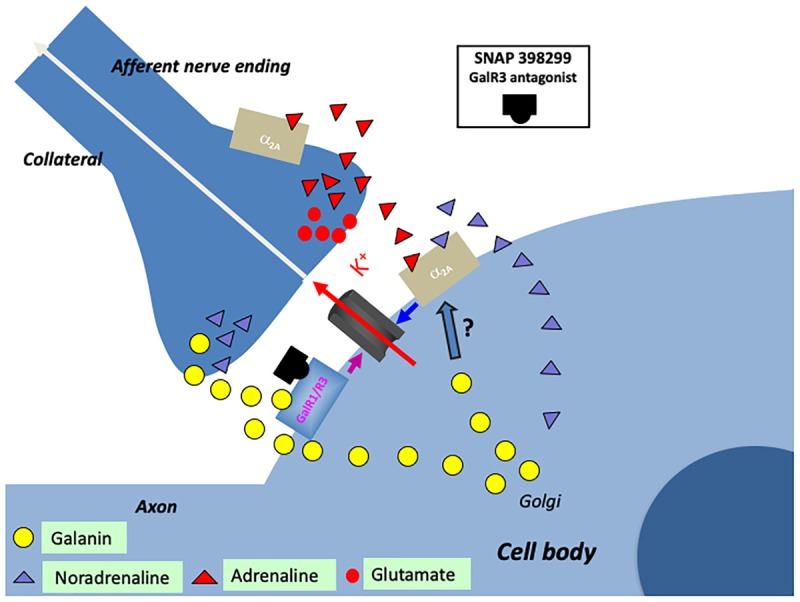
Cartoon showing several transmitters and signaling pathways in the locus coeruleus (LC) (part of a cell body with initial axon and an afferent nerve ending and a possible axon collateral). A noradrenergic LC neuron co-expresses galanin (yellow LDCVs) originating in the Golgi complex. The peptide in the LDCVs is, after transport to the somatic and dendritic cell membrane, released by exocytosis. Galanin then acts on inhibitory autoreceptors (GalR1/R3), opening potassium channels, in this way attenuating noradrenaline (NA) release in the forebrain. Galanin at low concentrations enhance the alpha2A mediated inhibition of the LC neuron (by an unknown mechanism). Galanin could also be released from collaterals. The GalR3 antagonist (SNAP 398299) may exert an antidepressive action by disinhibiting the LC neuron and restituting forebrain NA levels. With regard to small transmitters, NA (purple triangles) can be released from soma-dendrites and collaterals, acting on somato-dendritic, postsynaptic and presynaptic alpha2A receptors. The afferent nerve ending originates from C1 neurons which are glutamatergic (red dots) and co-release adrenaline (red triangles). Also adrenaline can act on the alpha2A receptors. The basis for this cartoon is animal experiments, and in the case of the galanin system, results from human postmortem brains are also incorporated.